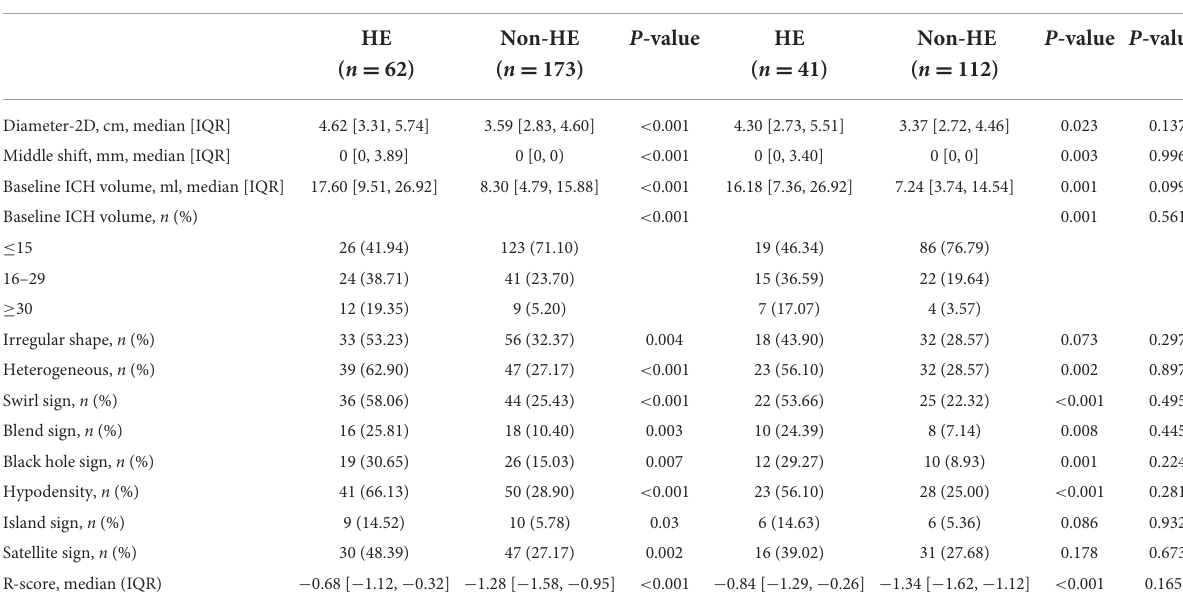
TABLE 3 Comparison of radiological characteristics and R-score between patients with and without HE.